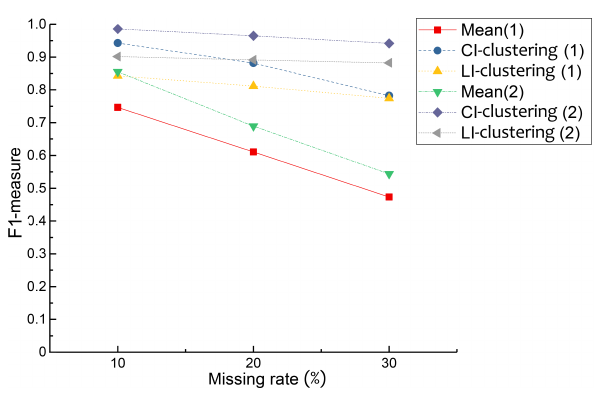
Fig. 9 Experimental results of real-world datasets.